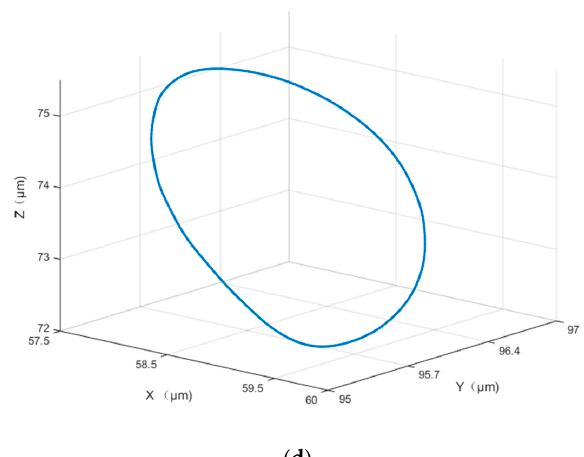
Figure 35. Experimental scenario 2. ( a ) x -direction input signal; ( b ) y -direction input signal; ( c ) z -direction input signal; ( d ) output trajectory.